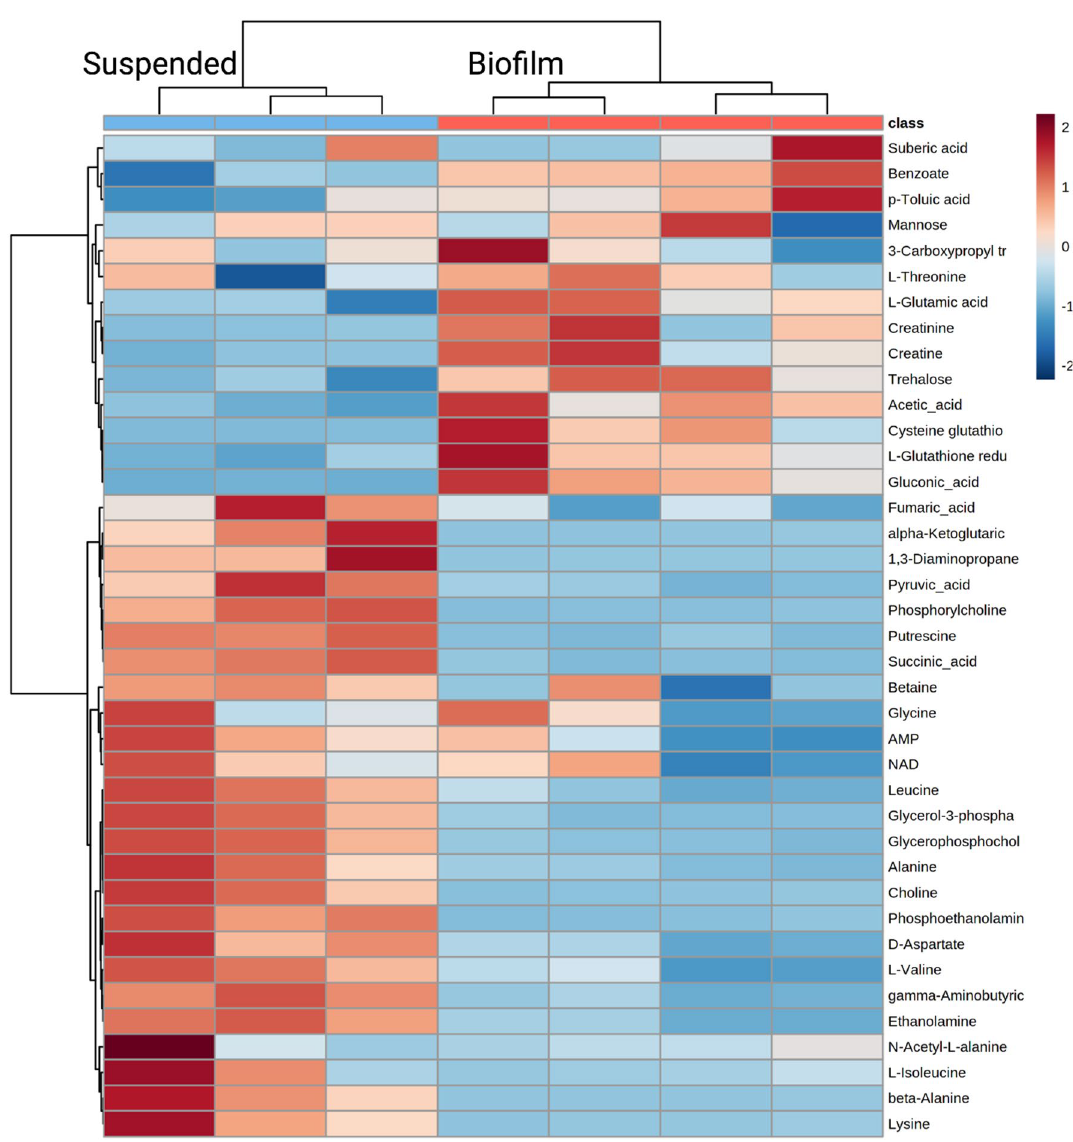
Figure 4. A quantitative visualization of metabolites identified in P. aeruginosa suspended culture and lawn biofilm samples by a heatmap. The map uses hierarchical clustering to accurately cluster samples into their respective cohorts (see text). The color scale shows metabolite fold changes between